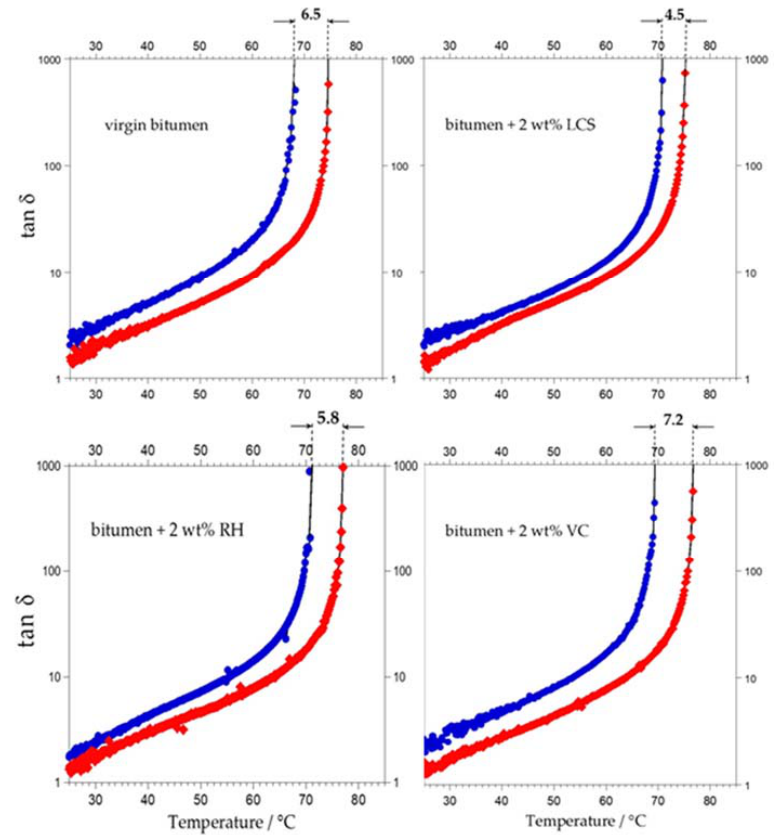
Figure 3. Time cure curves for virgin bitumen and bitumens modified with 2% w / w of LCS, RH and VC antioxidant additives, respectively. The increments of viscoelastic-sol transition temperature between aged (red symbols) and unaged (blue symbols) samples are indicated on the top axis of each graph. Upon addition of 2% w / w of anti-oxidants a slight increase of T TR is observed for unaged samples, 69.4 ◦ C (VC), 70.6 ◦ C (LCS) and 71.2 ◦ C (VC) compared to virgin bitumen 68.1 ◦ C. The shift ∆ T ( ± 0.2 ◦